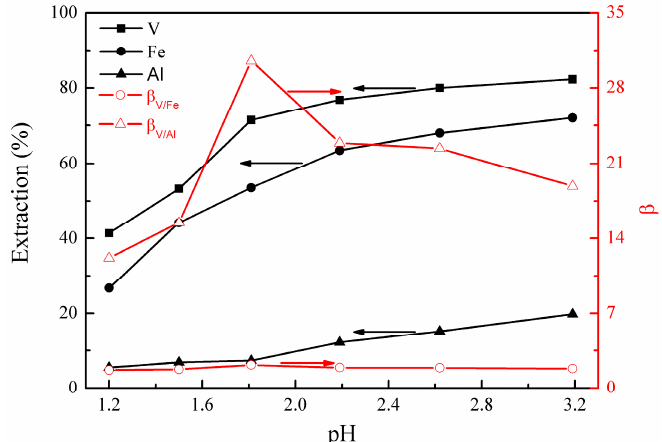
Figure 1. Effect of initial pH on the extraction percentages of V (IV), Fe, and Al, as well as on the separation factors β V/Fe and β V/Al .